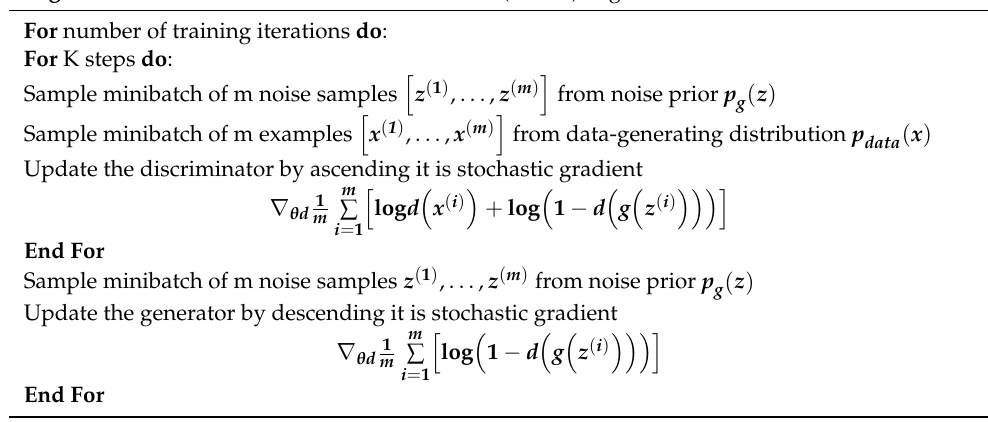
Algorithm 1: Generative Adversarial Networks (GANs)